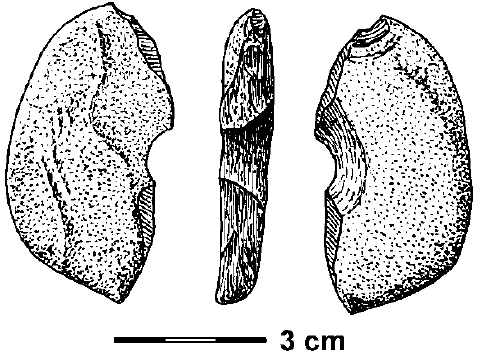
Figure 13. Three views of a drilled and fractured stone pendant from the Shiyu site.